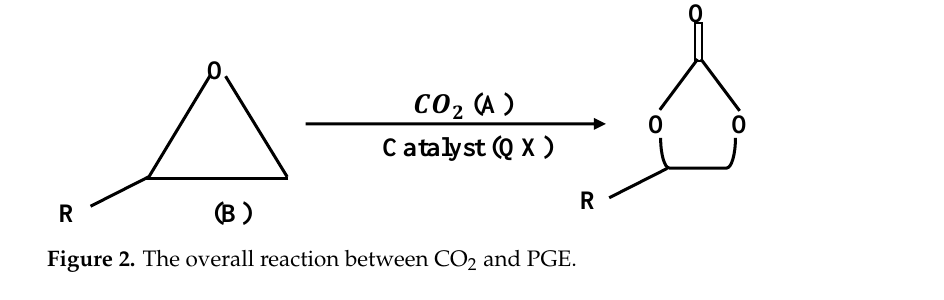
Figure 1. The schematic view of the stirred cell absorber.